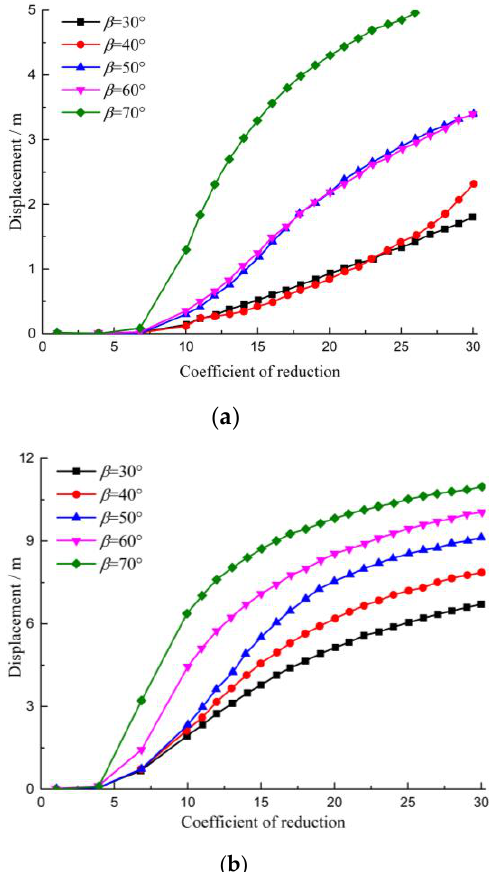
Figure 10. Variation curve of ridge apex displacement with reduction coefficient under different β ; (a) α =20°, H =10 m; (b) α =20°, H =20m.